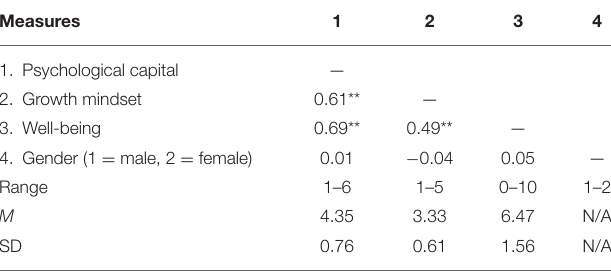
TABLE 1 | Descriptive analysis and correlations between all variables ( n = 1,384). Measures